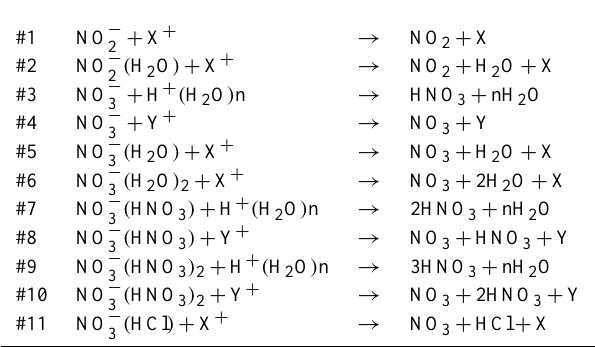
Table 1. List of ion–ion recombination reactions in which nitrogen is released from negative ions. X + denotes any positive ion, Y + any positive ion except H + ( H 2 O ) n clusters. X and Y are corresponding neutral species. n is the order of water clustering (i.e. a number be- tween 1 and